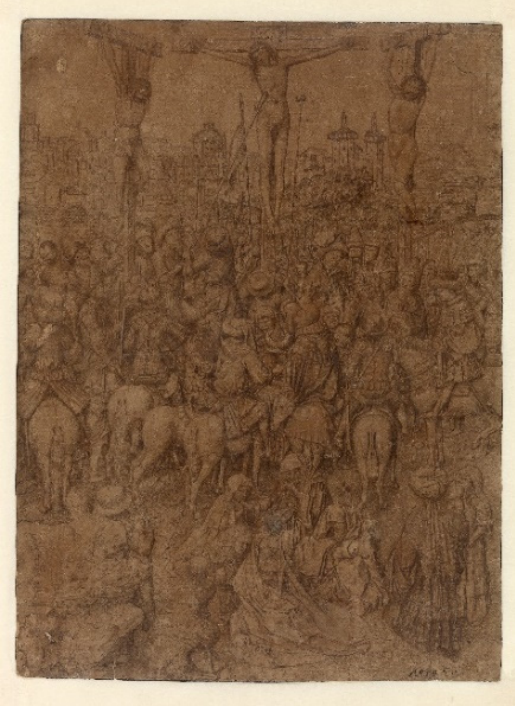
Figure 11. Jan van Eyck, workshop or follower, Crucifixion, ca. 1440–1480, Rotterdam, Museum van Boijmans Beuningen.